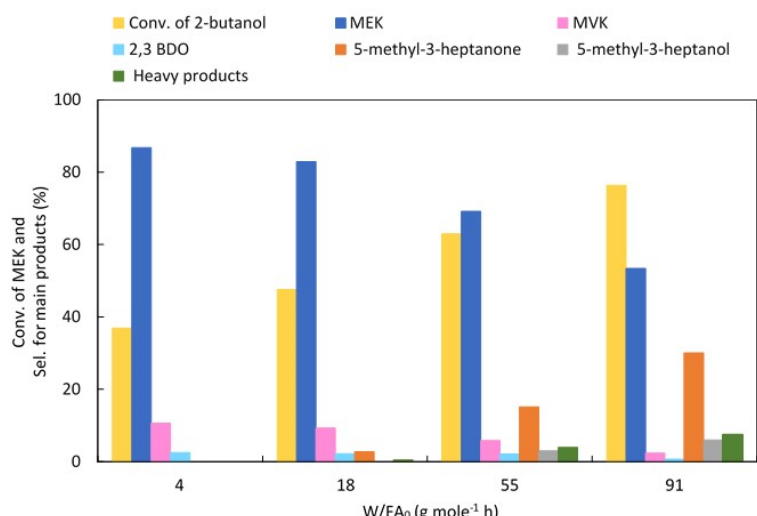
Figure 7. Catalytic results for the conversion of 2-butanol to a variety of products with different space times after 1 h of the reaction. Reaction conditions: catalyst weight, 1.0 g (15 wt % Cu–ZrO 2 ); feed rate of 2-butanol, 1.0 mL/h; H 2 /2-butanol molar ratio, 2; reaction temperature, 180 ◦ C. Heavy products include C 12 ketone, C 12 alcohol, condensation products, and so